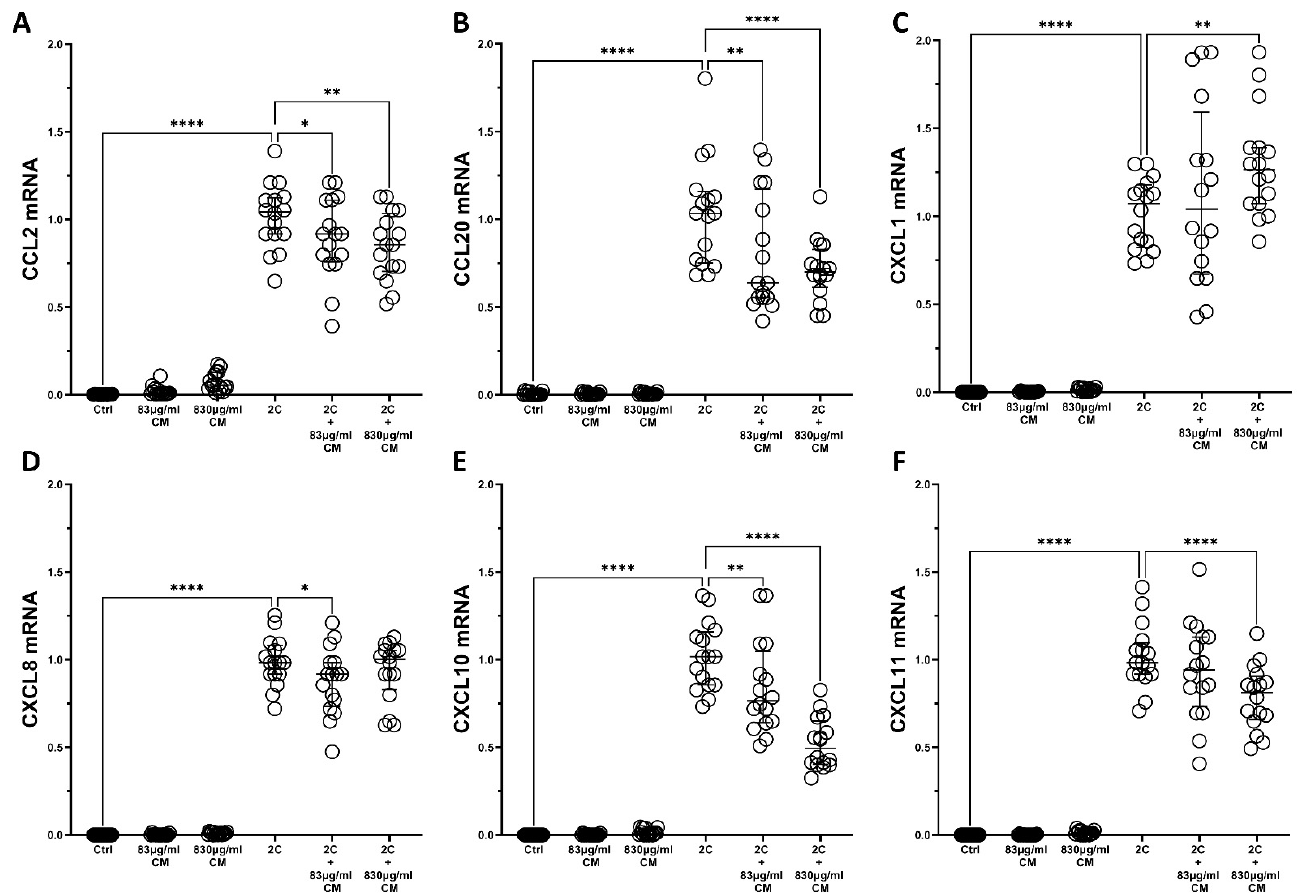
Figure 2. The effect of CM on chemokine mRNA expression in hPSMs, which are under pro-inflammatory stimuli. The CM inhibit the mRNA expression of chemokines CCL2 ( A ), CCL20 ( B ), CXCL10 ( E ) and CXCL11 ( F ) in a dose-dependent way, but have no effect on the mRNA levels of CXCL1 ( C ) and CXCL8 ( D ). 2C: IL-1 α 5 ng/mL + TNF- α 50 ng/mL; 830 μ g/mL total protein of CM; 83 μ g/mL total protein of CM. Results are presented as median with interquartile range. **** p < 0.0001; ** p < 0.01; * p < 0.05. N = 4.